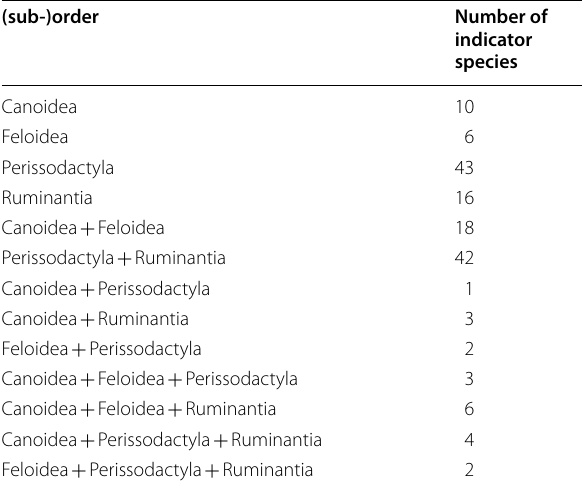
Table 1 Microbial indicators for different animal (sub-)orders and their